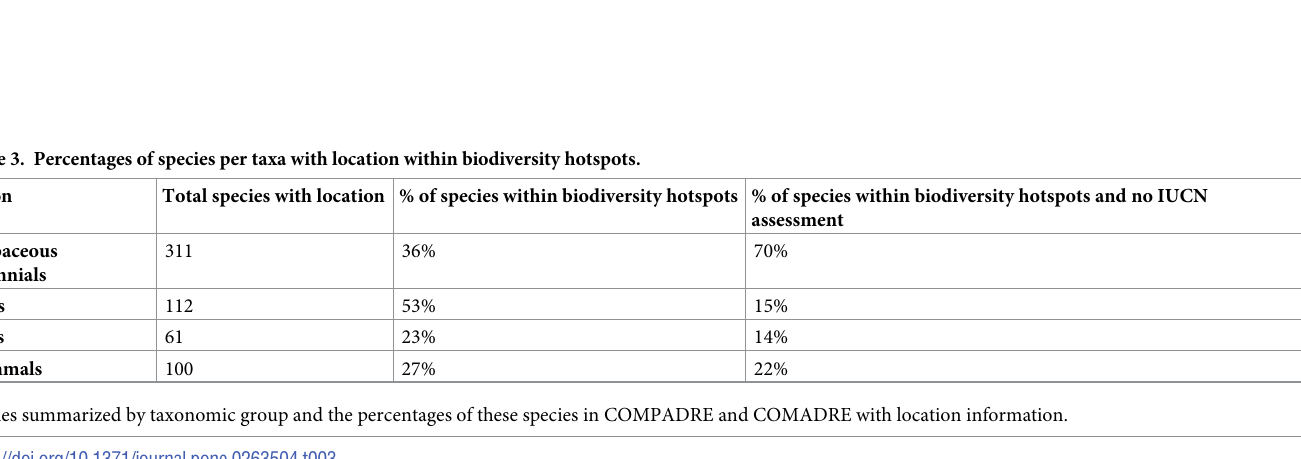
Fig 4. Spatial distribution of species in the COMPADRE and COMADRE matrix databases. Species with and without IUCN status assessment and relative to known biodiversity hotspots. Some species in the databases do not have data on geographic location and therefore were not included in the figure: 28 mammal species (29% without IUCN assessment), 24 bird species (13% without IUCN assessment), 29 tree species (17% without IUCN assessment), and 111 herb species (79% without IUCN assessment).